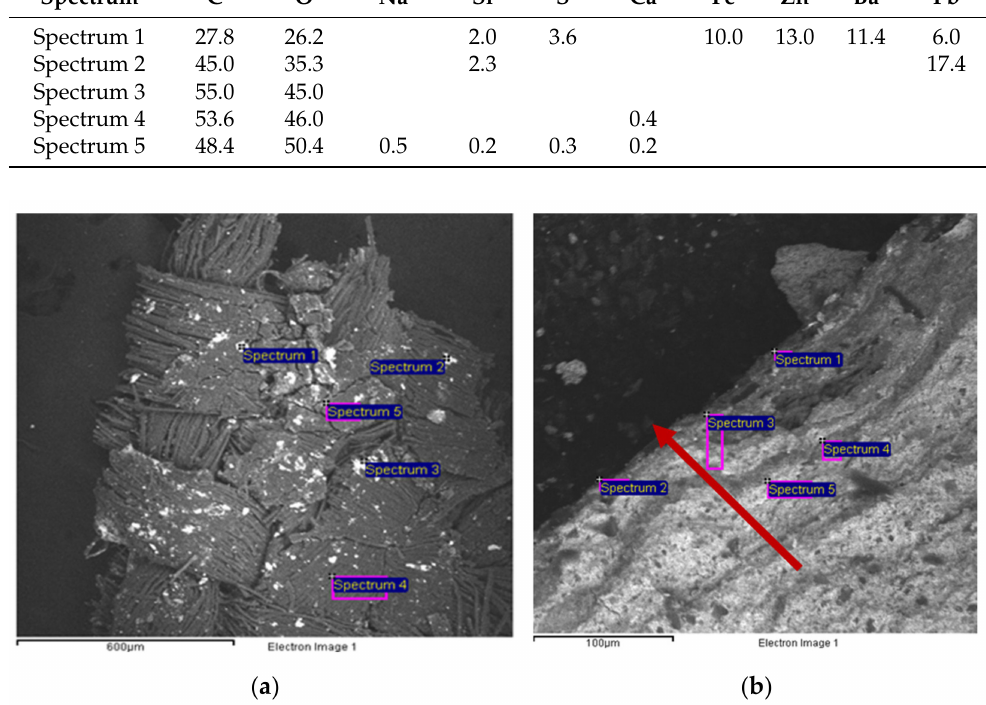
Figure 5. SEM images showing sample 1, consisting of the whole stratigraphy from the original canvas to the varnish layer. Image of the canvas (backside) ( a ) with the indication of the analyzed areas corresponding to the results in Table 1. Image of the layers from the preparation layer (arrowhead) to the paint layer on the top (starting point of the arrow) ( b ) with the indication of the analyzed areas corresponding to the results in Table